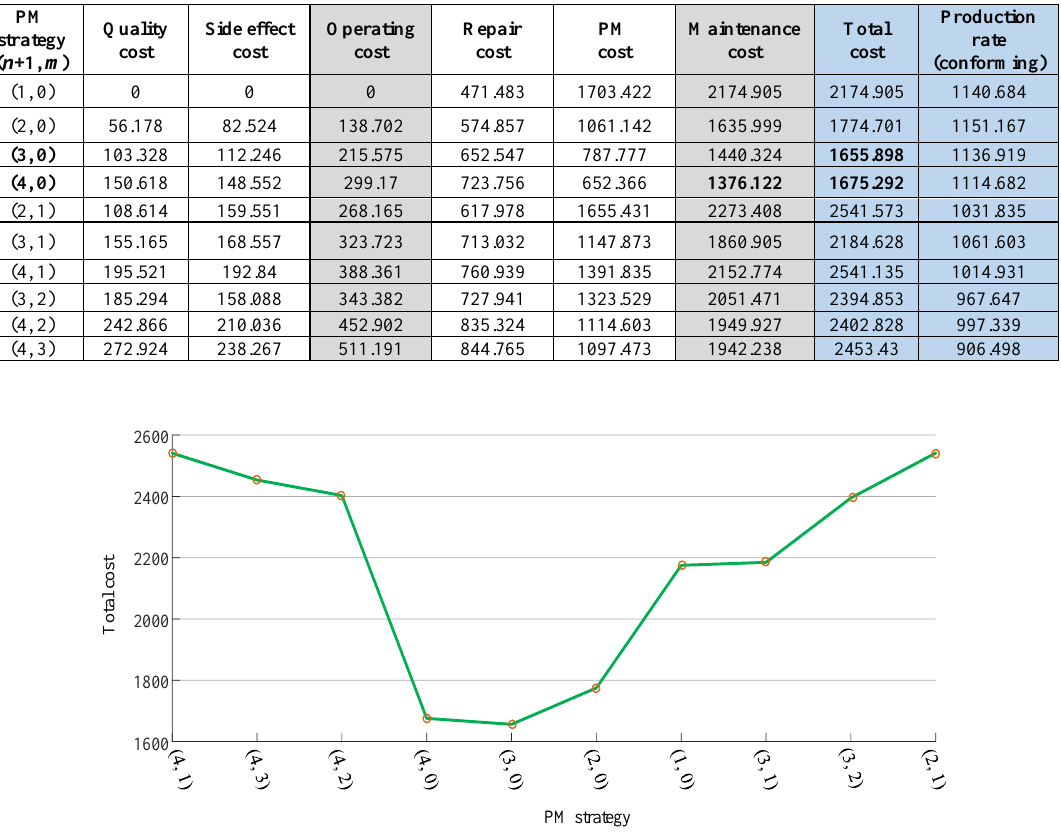
Table 5. Optimization model results.